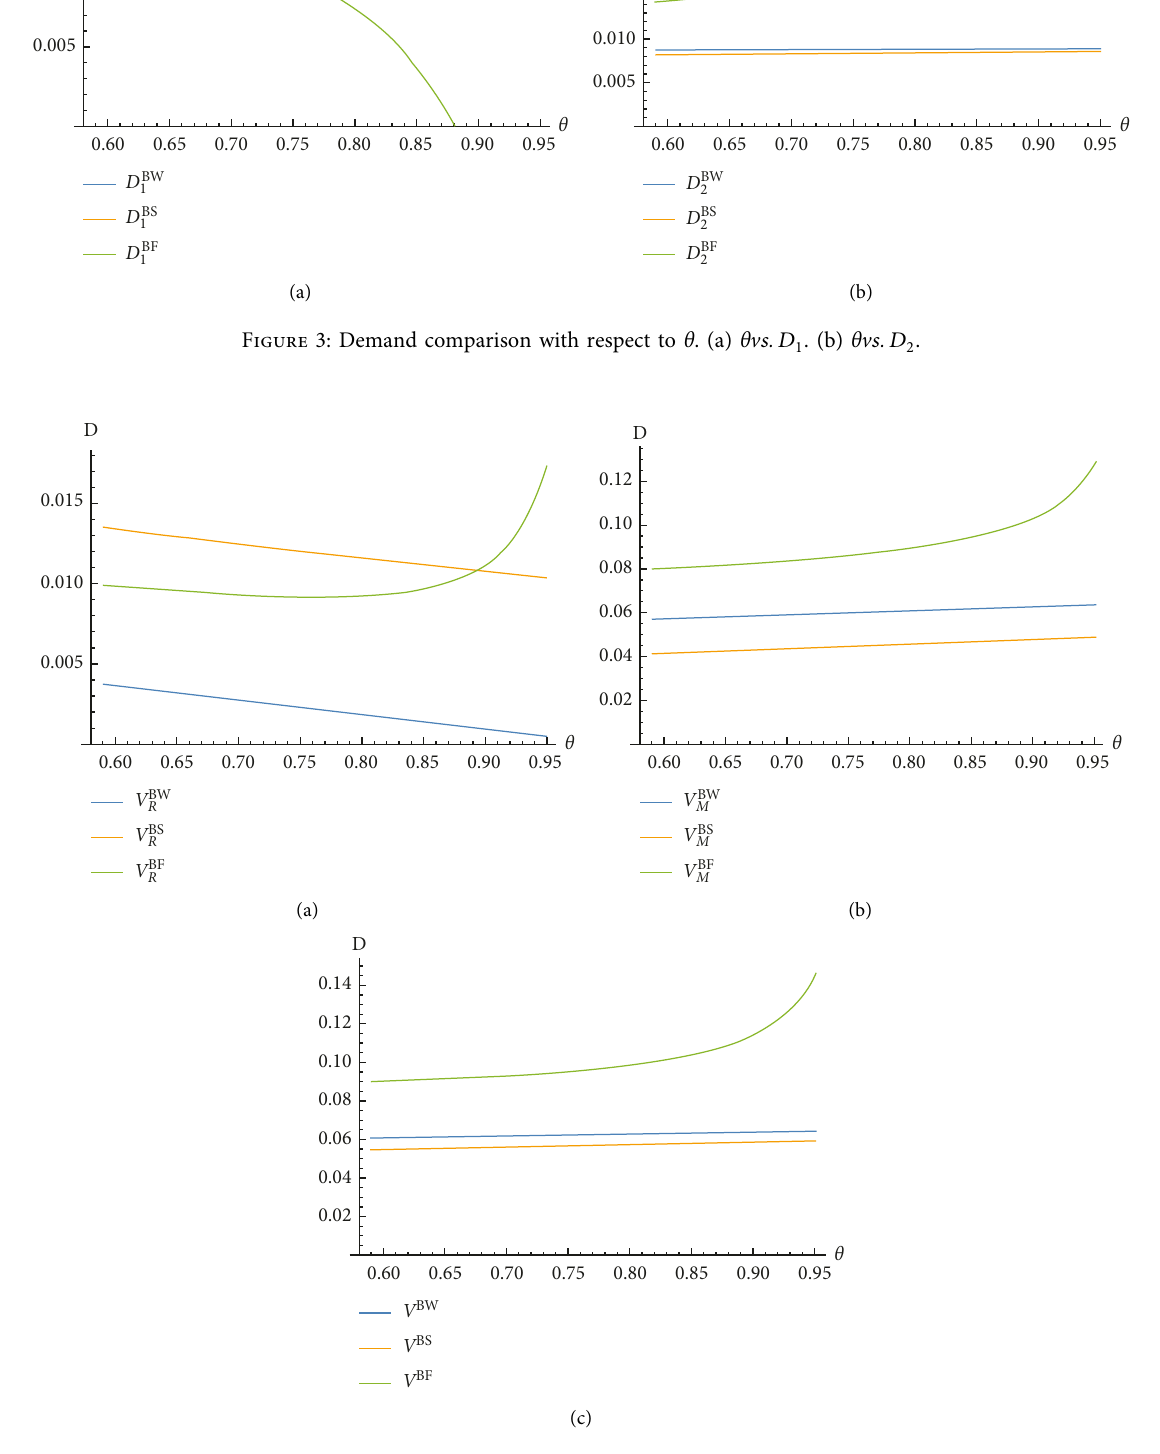
vs. V vs. V R . (b) θ M . (c) θ